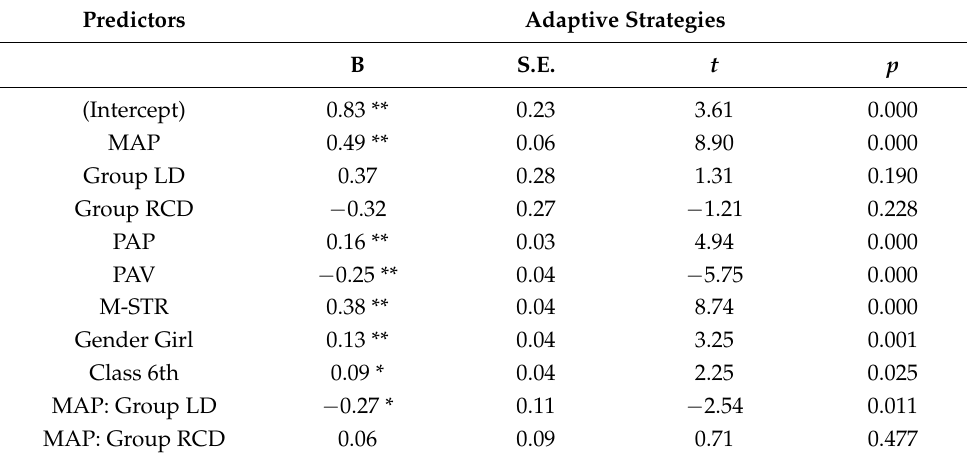
Table 6. Model 4: Linear regression analysis for predicting adaptive